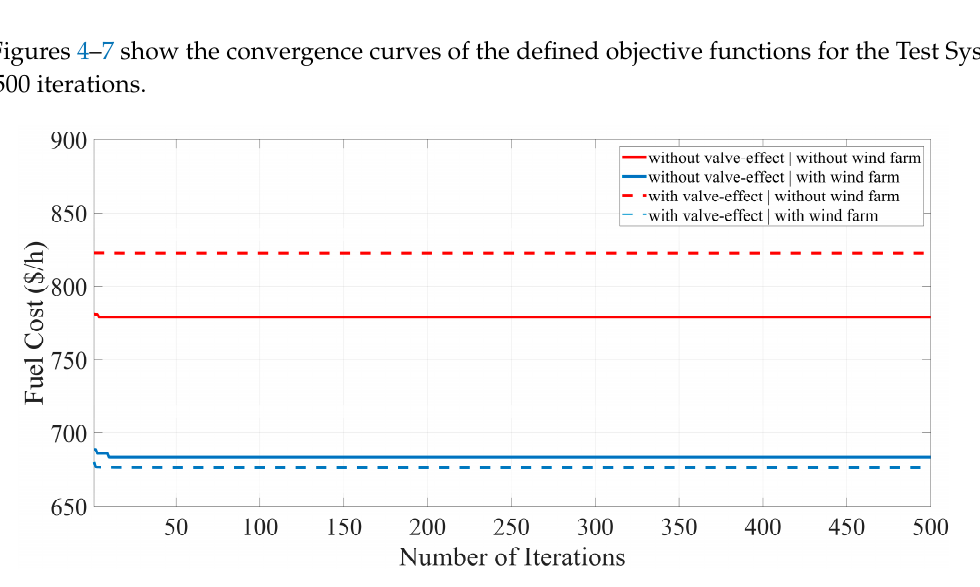
Figure 6. The convergence curves for emission minimization for the Test System 1. Figure 7. The convergence curves for CEEC minimization for the Test System 1.